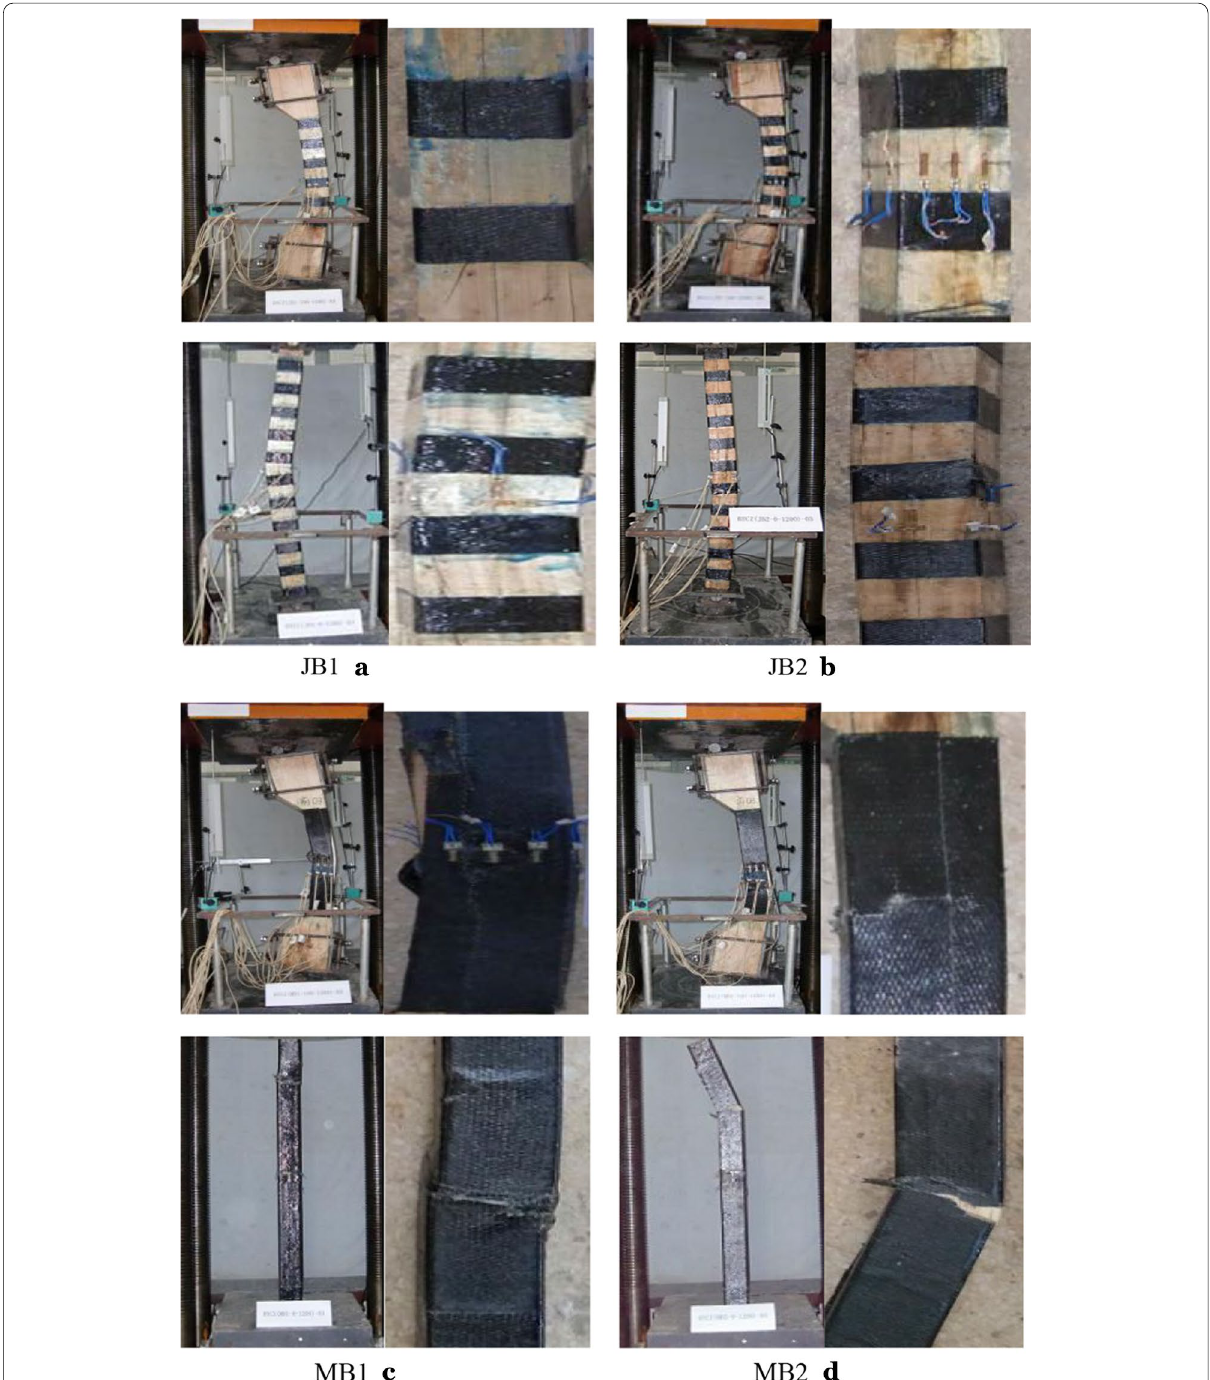
Fig. 8 Failure mode of reinforced column with an eccentricity of 0 mm and 100 mm under